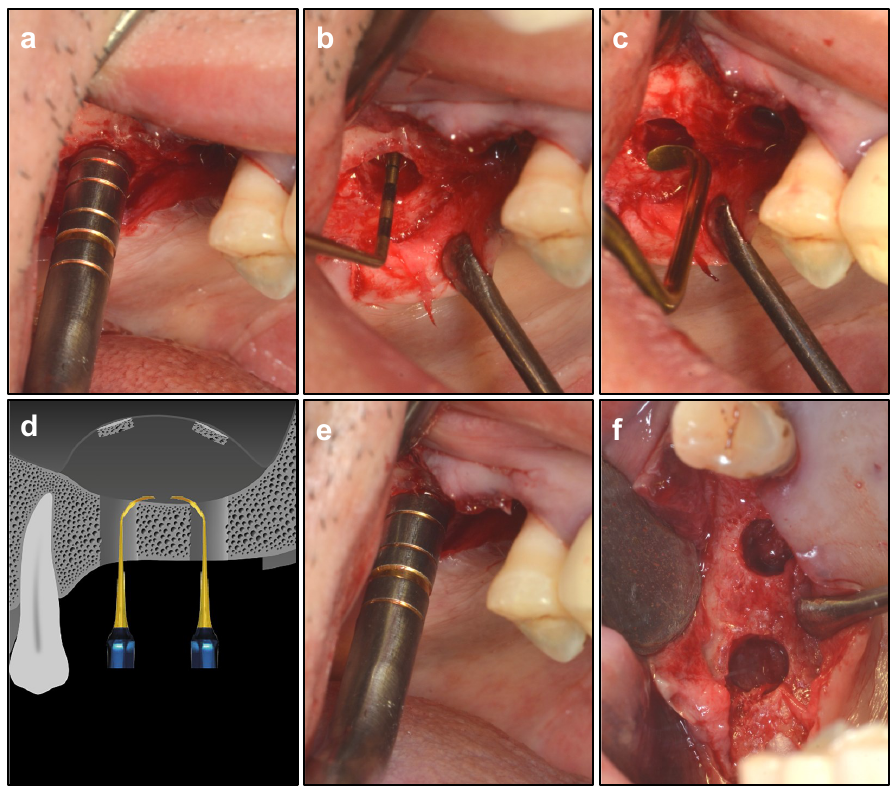
Figure 3. Schneiderian membrane elevation. ( a ) using osteotome to elevate the sinus membrane (>1 mm). ( b ) using dome-shaped sinus curette to lift the membrane. ( c ) using variously shaped detachers in Dentium Advanced Sinus Kit (DASK) to detach the membrane. ( d ) using detachers to elevate the membrane between 2 implants. ( e ) using osteotome to ascertain the height of elevation. ( f ) integrated membrane after